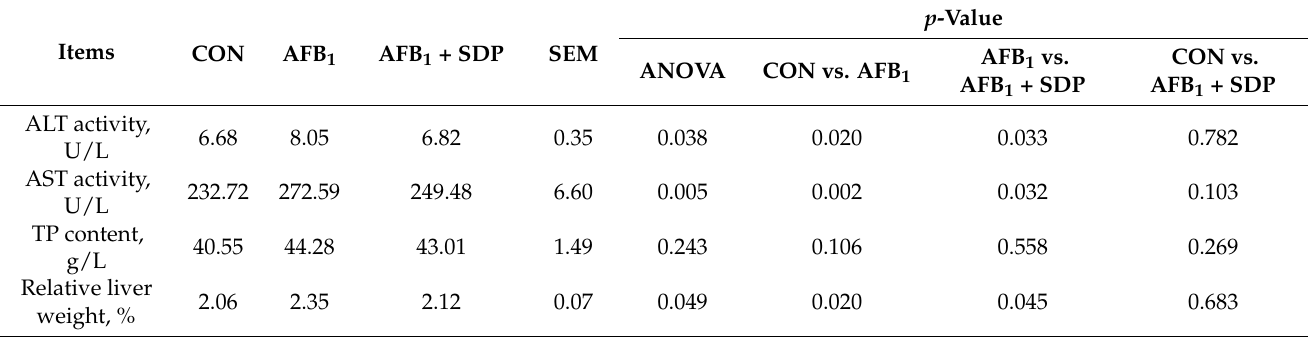
Table 2. The impacts of polysaccharides from seaweed ( Enteromorpha prolifera ) on serum liver function- related indexes and relative liver weight of broiler chickens exposed to AFB 1